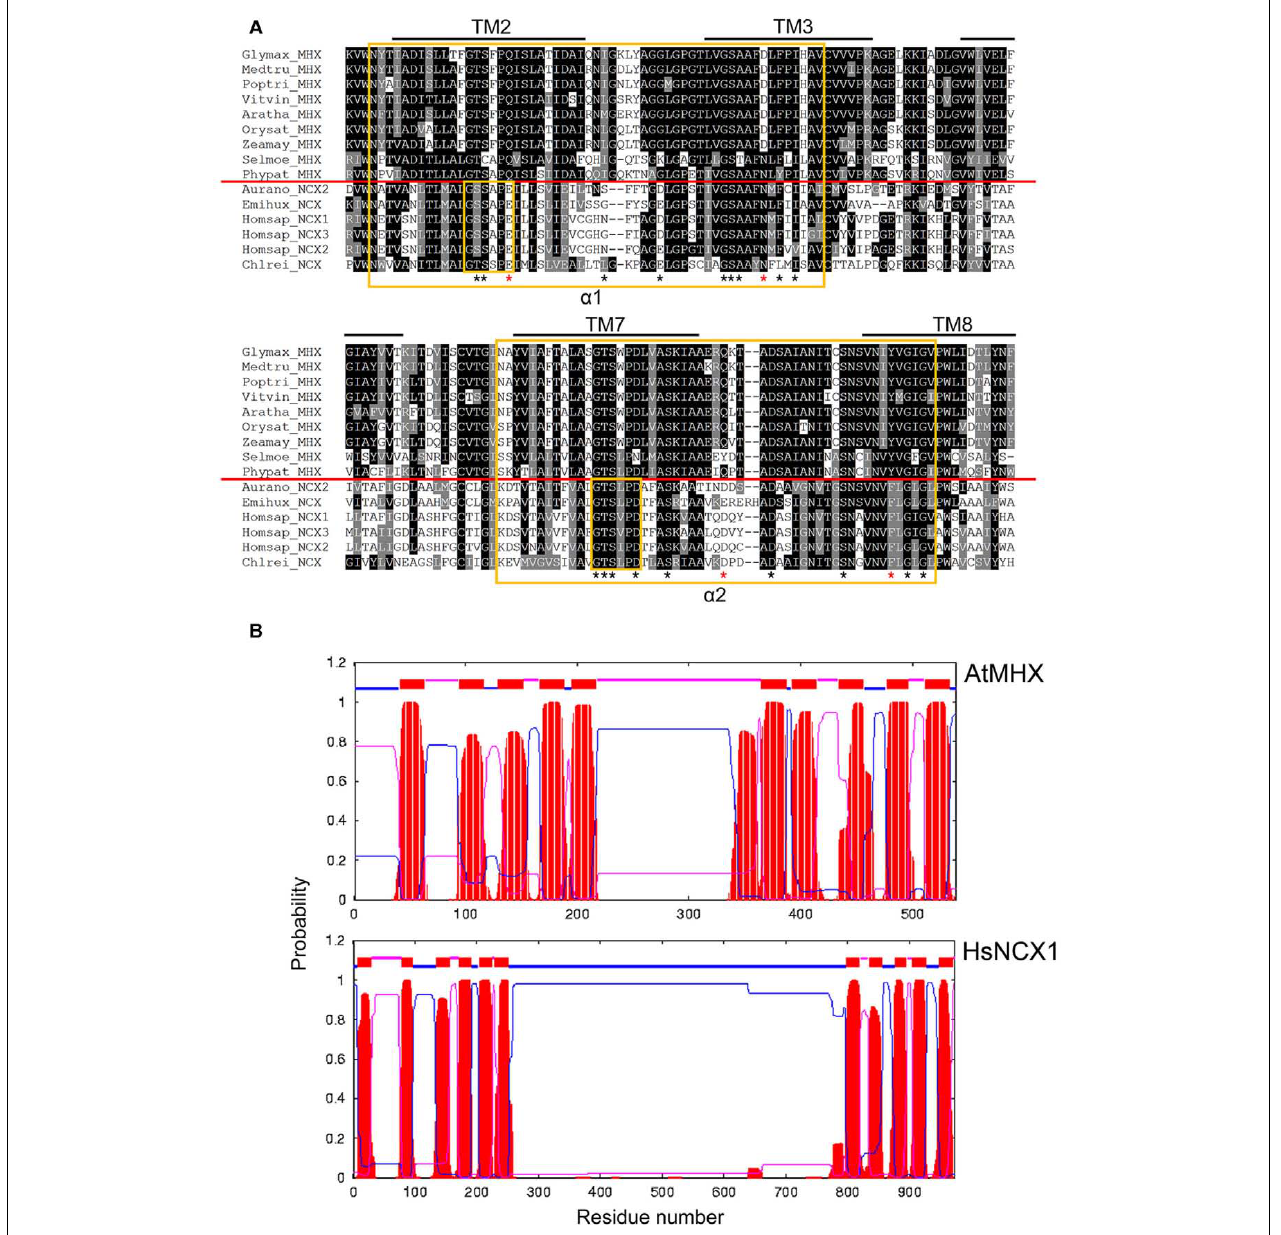
over-lined.The α -repeat regions and signature residues are boxed in yellow. The red line separates the MHX and NCX sequences. Asterisks indicate residues shown to be important for Na + /Ca 2 + exchange activity in NCX1, with those in red being not conserved in the MHX sequences. (B) Topology models of AtMHX and HsNCX1 generated byTMHMM. Red areas indicate predictedTM